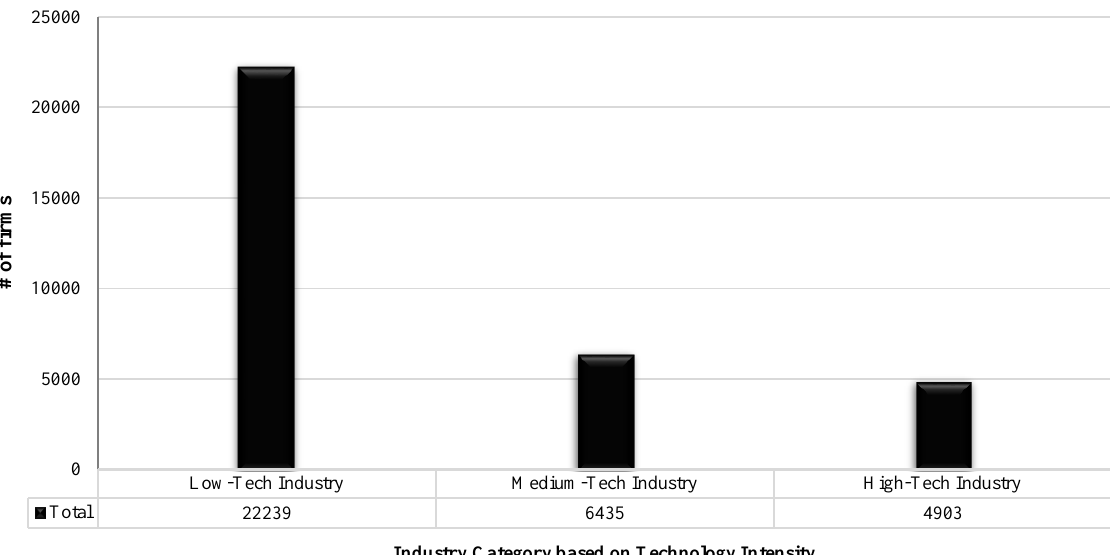
Figure 3. Indonesian manufacturing industry based on technology